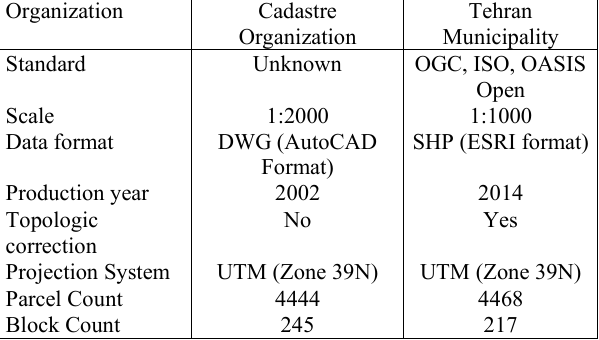
Table 1. The metadata of the employed maps